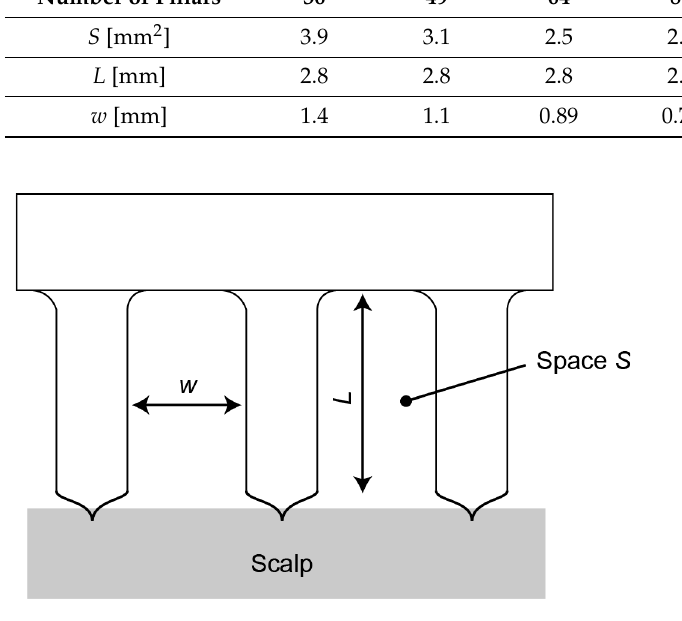
Table 1. Configuration of tested electrodes.